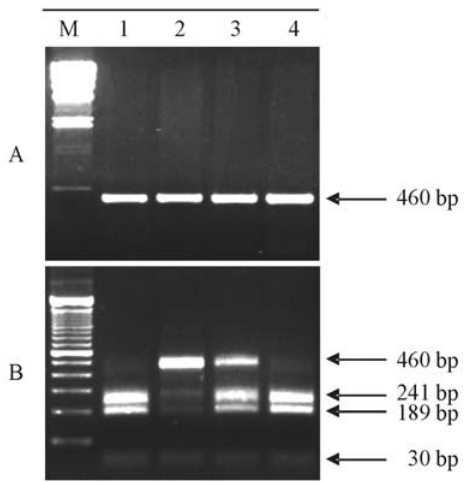
Figure 1 - JAK2 V617F screening by PCR and Bsa XI digestion. Lanes 1-3: Patients with (1) essential thrombocythemia, ET; (2) polycythemia vera, PV; (3) idiopathic myelofibrosis, IMF. Lane 4: Control individual. (A) 460 bp undigested PCR product; lane M, λ - Hind III fragments (New England BioLabs Inc.); (B) Bsa XI digestion of the 460 bp PCR product yields 241 bp, 189 bp and 30 bp fragments from the wild-type allele; the fragmentcorrespondingtothe JAK2 V617Fmutationremainsundigested: normalallelesinapatientwithET(1);anormalandamutatedalleleinpa- tients with PV (2) and IMF (3); normal alleles in a control individual (4). Lane M, 100 bp molecular weight ladder (New England BioLabs Inc.).